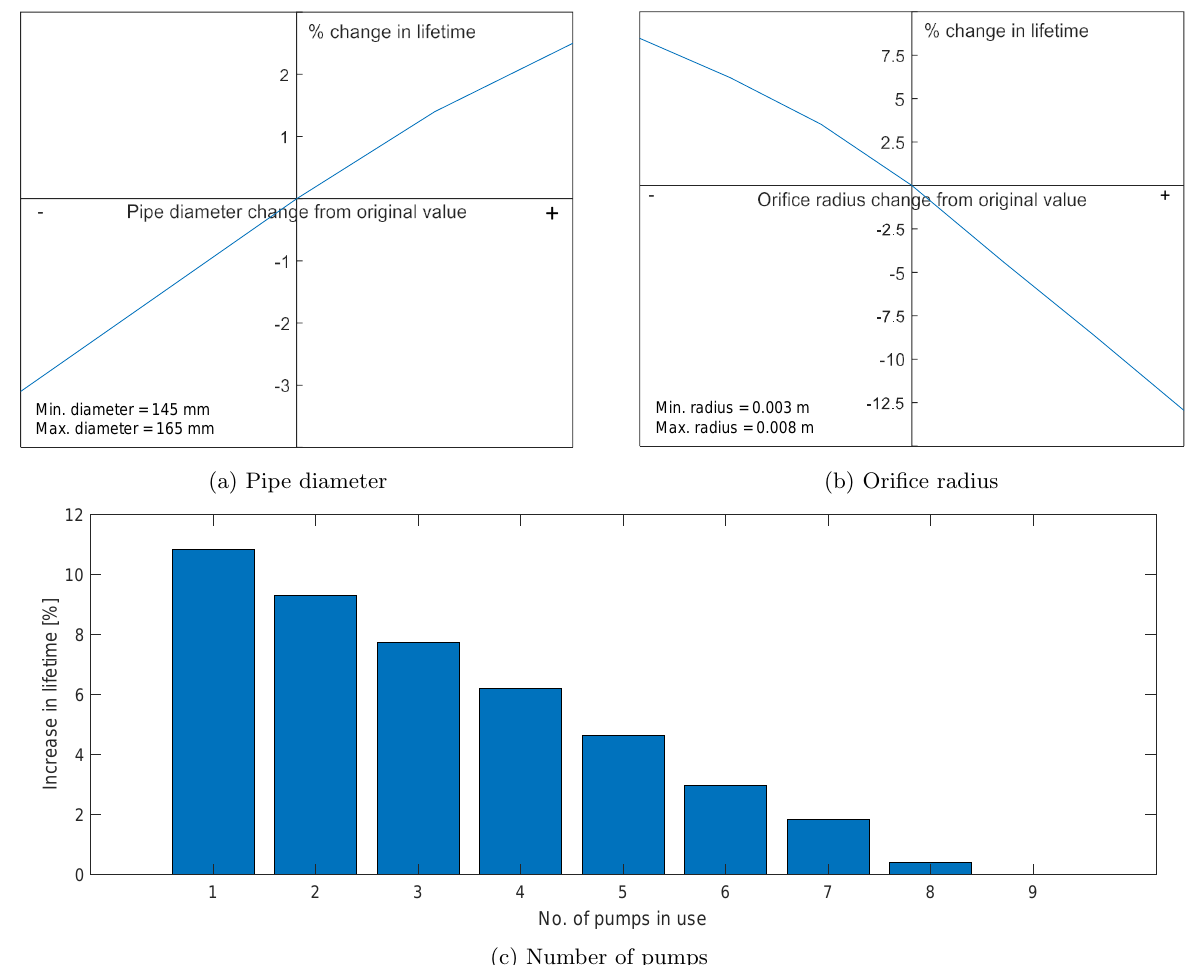
Figure 13: Effect diagrams for pipe diameter, orifice radius and number of pumps in use